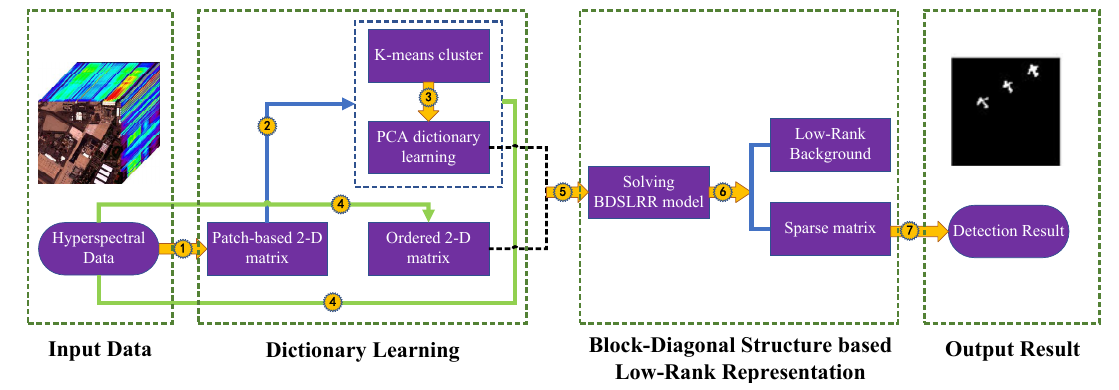
Figure 2. Framework of the proposed